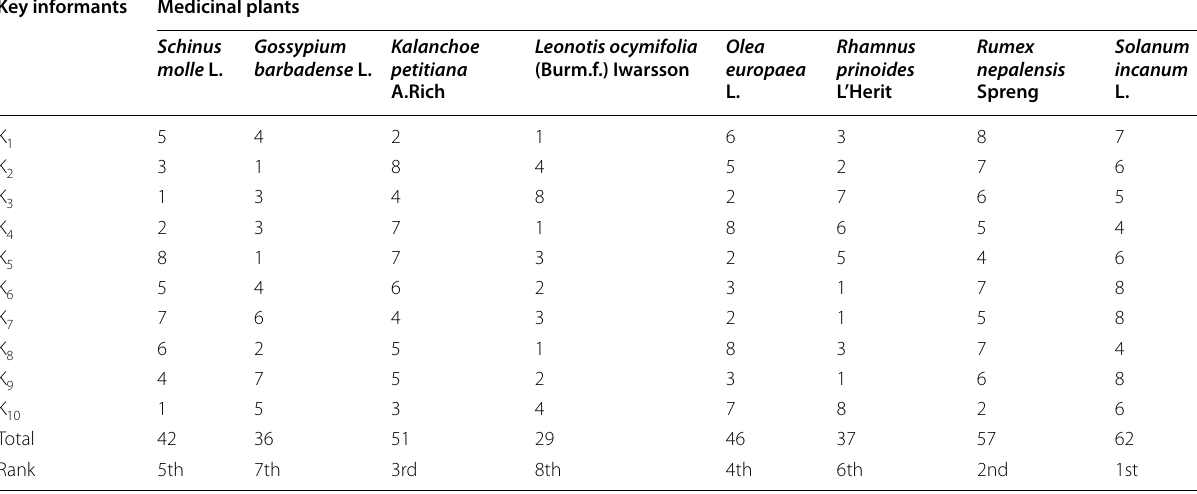
Table 5 Preference ranking of eight medicinal plants in treating tonsillitis Key informants Medicinal